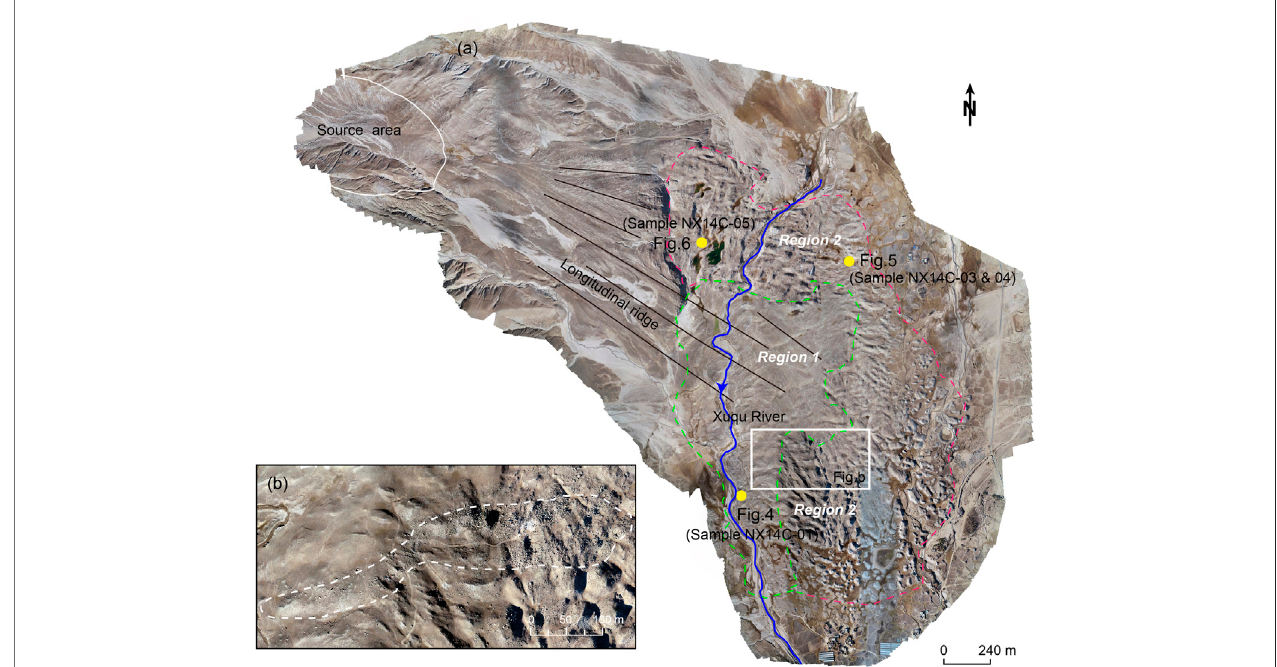
FIGURE 3 | High-resolution unmanned aerial vehicle (UAV) images showing that (A) two obvious different textural regions exist, and (B) The front material accelerated and climbed over the underlying terrain, forming carapace facies with abundant blocks of different sizes. The yellow dot is the 14 C sample site. Table 1 presentsthedetailedinformationaboutthesamples.SampleNXC14-01wascollectedfromthesedimentpro fi leexposedastheXuquRiverincisedintothemarginofthe NCRA ( Figure 4 ). In addition, Zeng et al. (2020) collected sample NXC-1 from the same location ( Figure 4 ). The 14 C age of sample NXC14-01 indicates that the landslide event occurred in region 1 with an age of 1,271 – 1,389 cal AD. Samples NXC14-03 and NXC14-04 were collected in the swales on the NCRA sediment body ( Figure5 ).SampleNX14C-05wascollectedfromthesmallpondontheNCRAsedimentbody( Figure6 ).Allofthesamplesindicatethatthelandslideeventoccurredin region 2 with an age of 425 – 565 cal